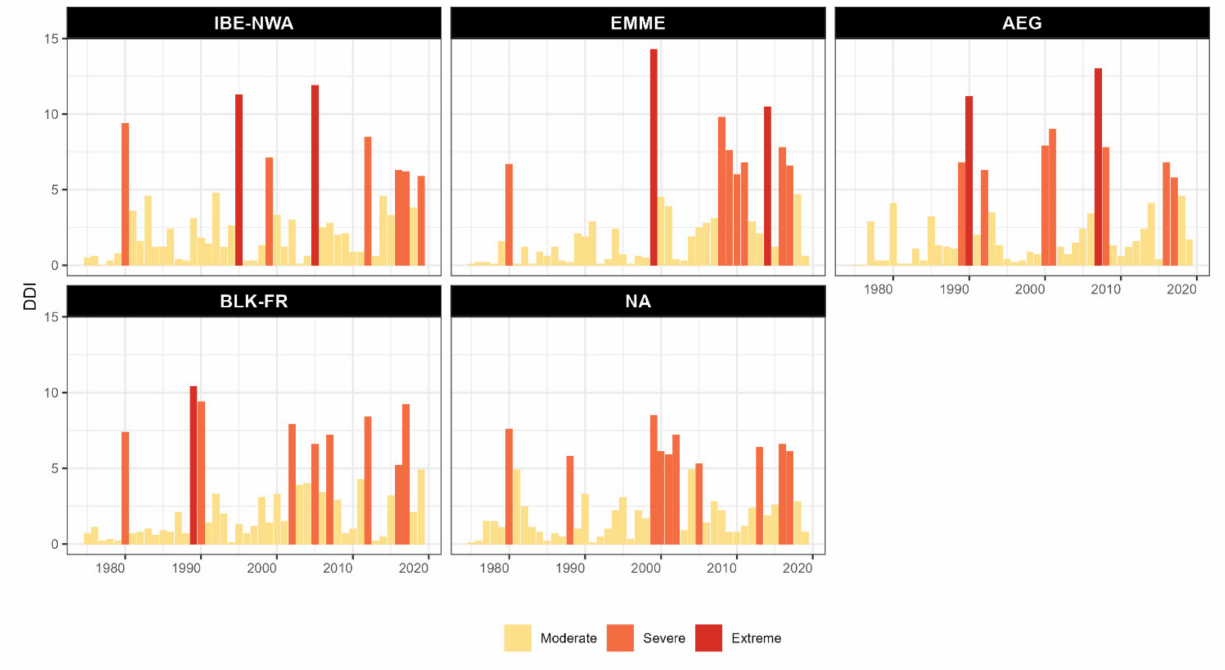
Figure 4. Temporal variations of the degree of dryness (DDIs) over all subregions during